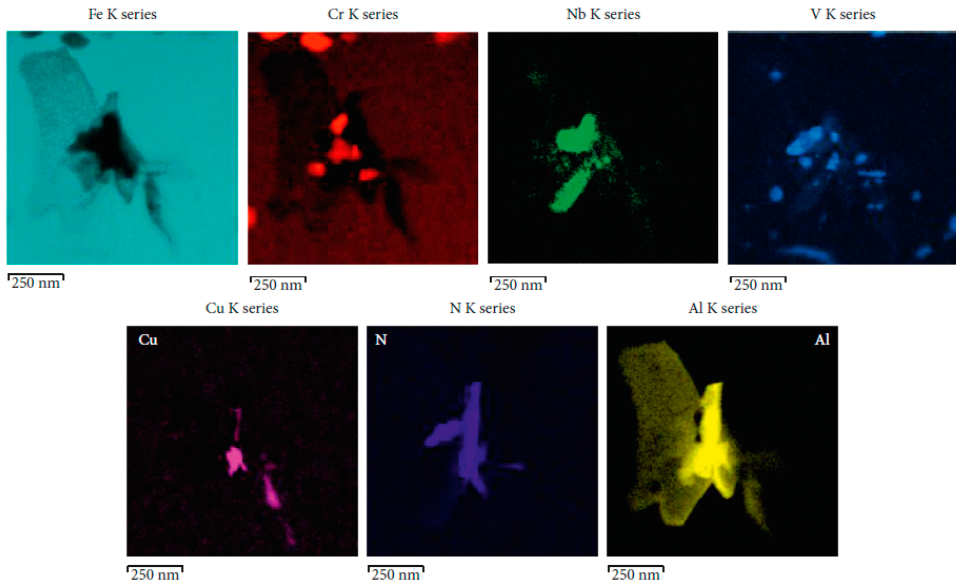
Figure 4. Detailed micrograph showing inclusions associated with an individual creep cavity as well as compositional maps showing the distribution of the elements Cr, Nb, V, Cu, N, and Al associated with this location.